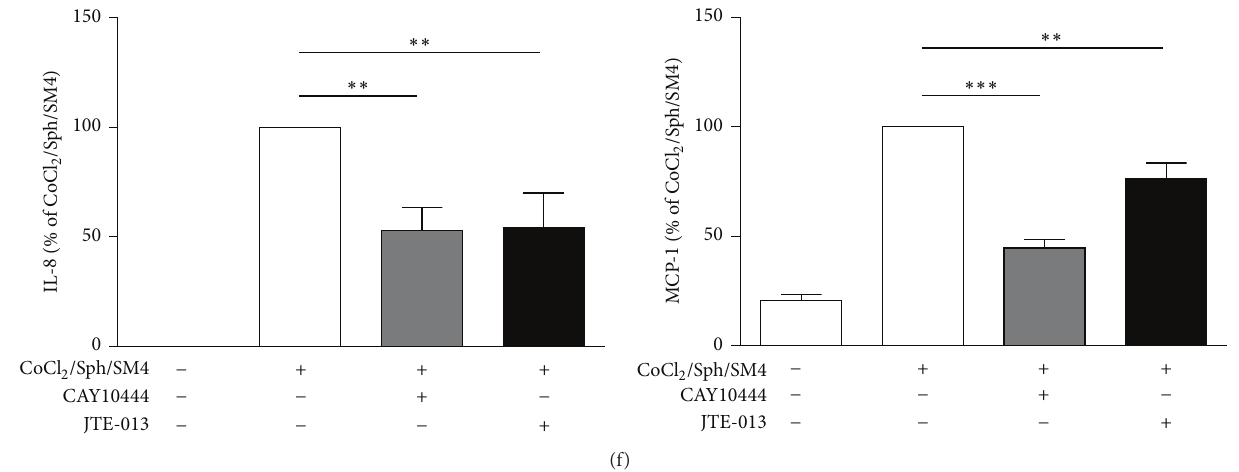
Figure 5: Impact of SPL inhibition on CoCl 2 -mediated chemokine/cytokine secretion in normal FLS and RAFLS. Human primary FLS from normal (a, c) and RA (b, d, e, f) donors were incubated with 200 𝜇 M CoCl 2 in the presence of SPL inhibitor SM4 (3 𝜇 M) or the inactive analog SM3 (3 𝜇 M) and sphingosine (1 𝜇 M) for 24 h. Where indicated, cells were pretreated with S1P 3 antagonist CAY10444 (5 𝜇 M) or S1P 2 antagonist JTE-013 (5 𝜇 M) for 30 min before stimulation with CoCl 2 in combination with sphingosine (Sph), SM4, or SM3. The data are the means ± SE from three experiments. For statistical comparative analyses, chemokine levels in the samples stimulated with CoCl 2 were compared to that of other samples (a–d) or chemokines produced by cells stimulated with CoCl 2 in combination with Sph and SM4 were compared to those produced by cells incubated with the S1P receptor antagonists prior to cell stimulation (f). ∗ 𝑝 < 0.05 ; ∗∗ 𝑝 < 0.01 ; ∗∗∗ 𝑝 < 0.001 . Cytokine/chemokine secretion in RAFLS supernatants was analyzed using Proteome Profiler Human Cytokine Array panel A (e). Circled pairs of duplicate spots represent one